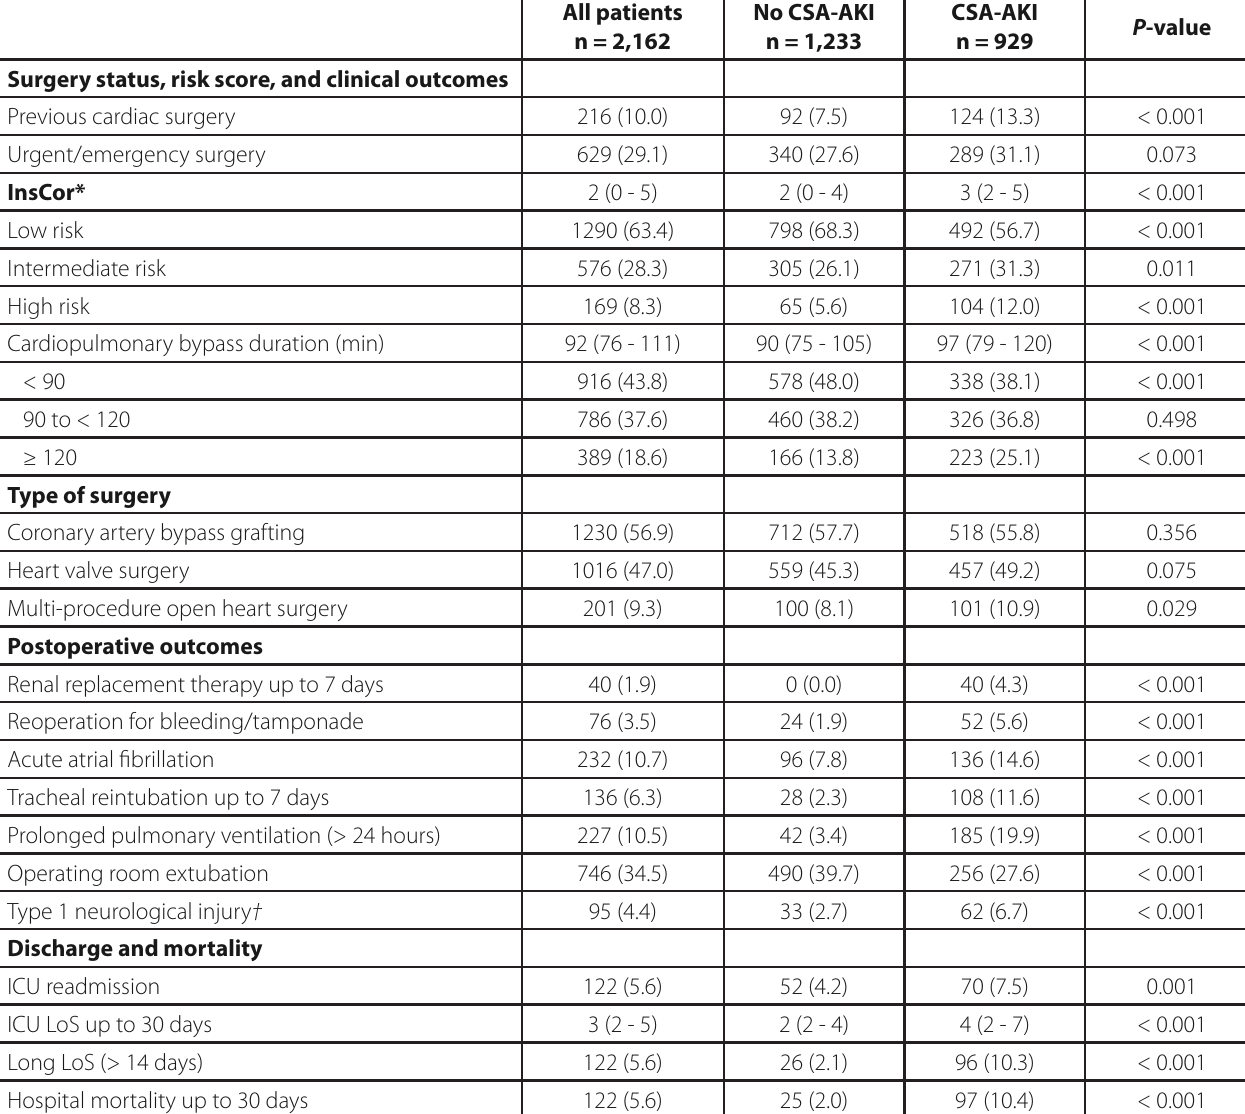
Table 2. Surgery status, risk score, and clinical outcomes of the 2,162 patients according to the development of CSA-AKI based on KDIGO